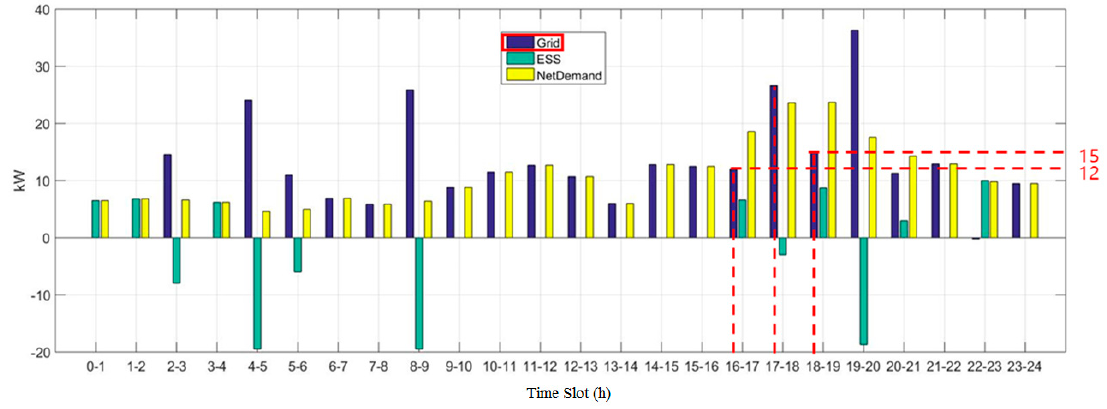
Figure 12. The application result of peak control.